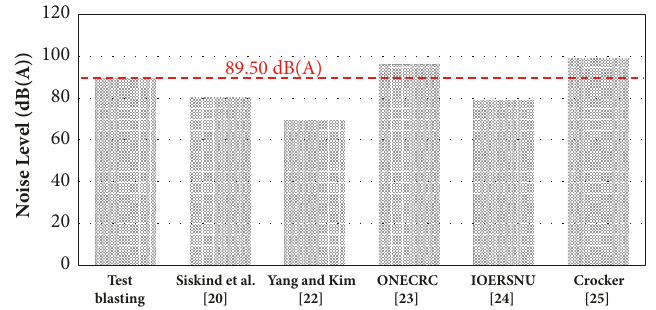
Figure 16: Graph for comparison of each noise level (based on Table